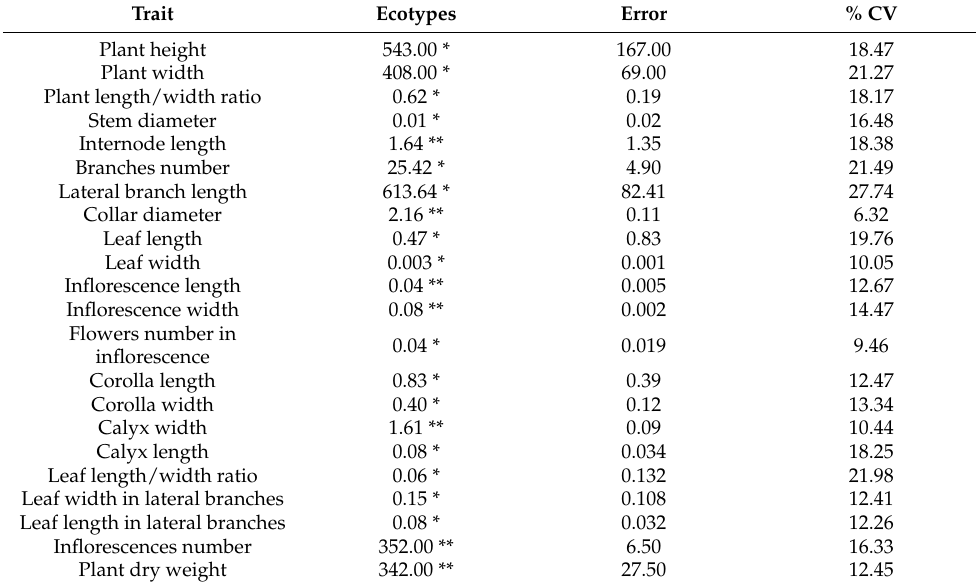
Table 2. ANOVAs for morphological traits of M. aquatica populations from the Hyrcanian hotspot of